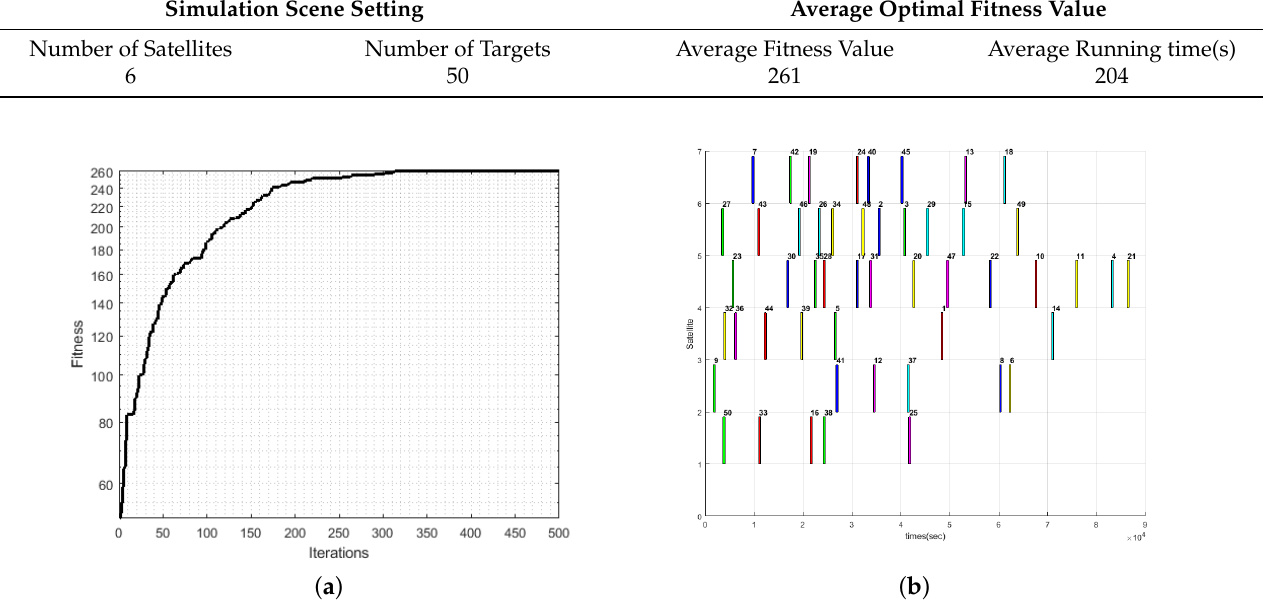
Figure 7. Typical simulation results of MSCATP Based on H-GASA: ( a ) Evolution curve of the algorithm, in which the x-coordinate is iterations, and the y-coordinate is fitness (corresponding to the planning results). ( b ) Gantt chart of multi-satellite cooperative task planning results, in which x-coordinate is times, and y-coordinate is satellite ID, each rectangle represents a task, with a number next to it is the task